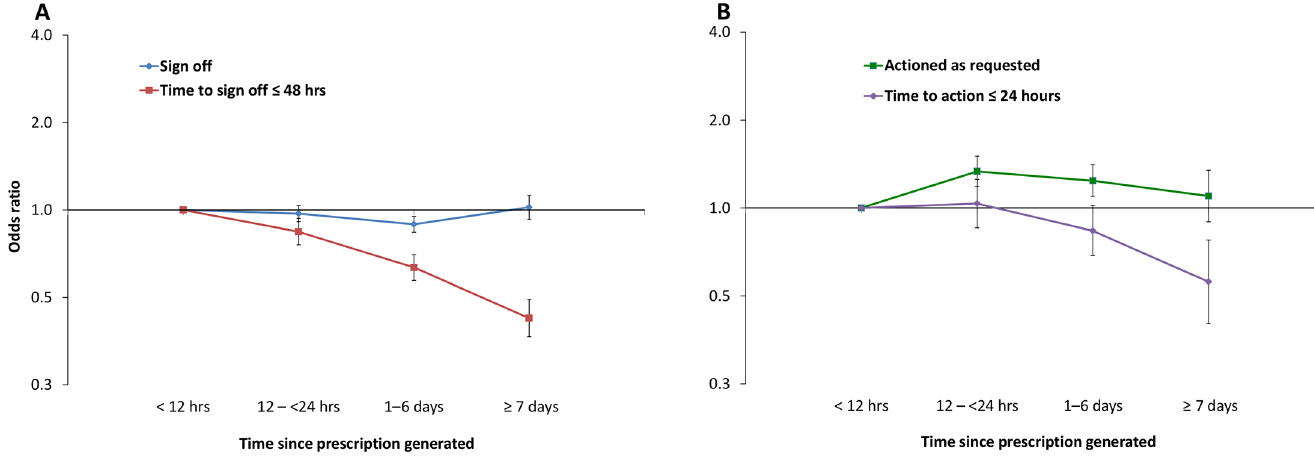
Fig 5. GEE model for the time since the prescription was generated to the message being assigned. A: Sign-off and time to sign-off in (cid:1) 48 hours; B: Action and time to action as requested in (cid:1) 24 hours. ORs (95% CI) from the GEE model described in S2 Appendix. < 12 hours is the reference